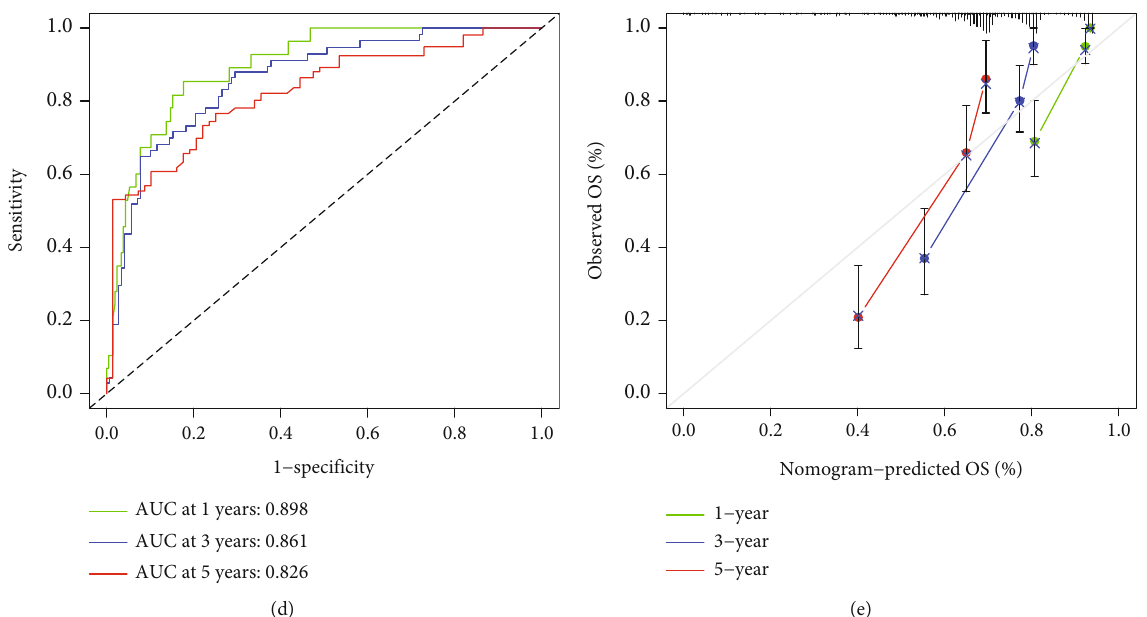
Figure 7: Univariate and multivariate Cox regression analyses and construction and analysis of nomogram. (a) Forest plot of univariate Cox regression analysis in TCGA-KIRC. (b) Forest plot of multivariate Cox regression analysis in TCGA-KIRC. (c) Nomogram constructed by combining based-IGPRM risk characteristic and clinical characteristics. (d) The 1-, 3-, and 5-year ROC and AUC predicted for the nomogram in the TCGA-KIRC cohort. (e) The calibration diagram of the nomogram for TCGA-KIRC